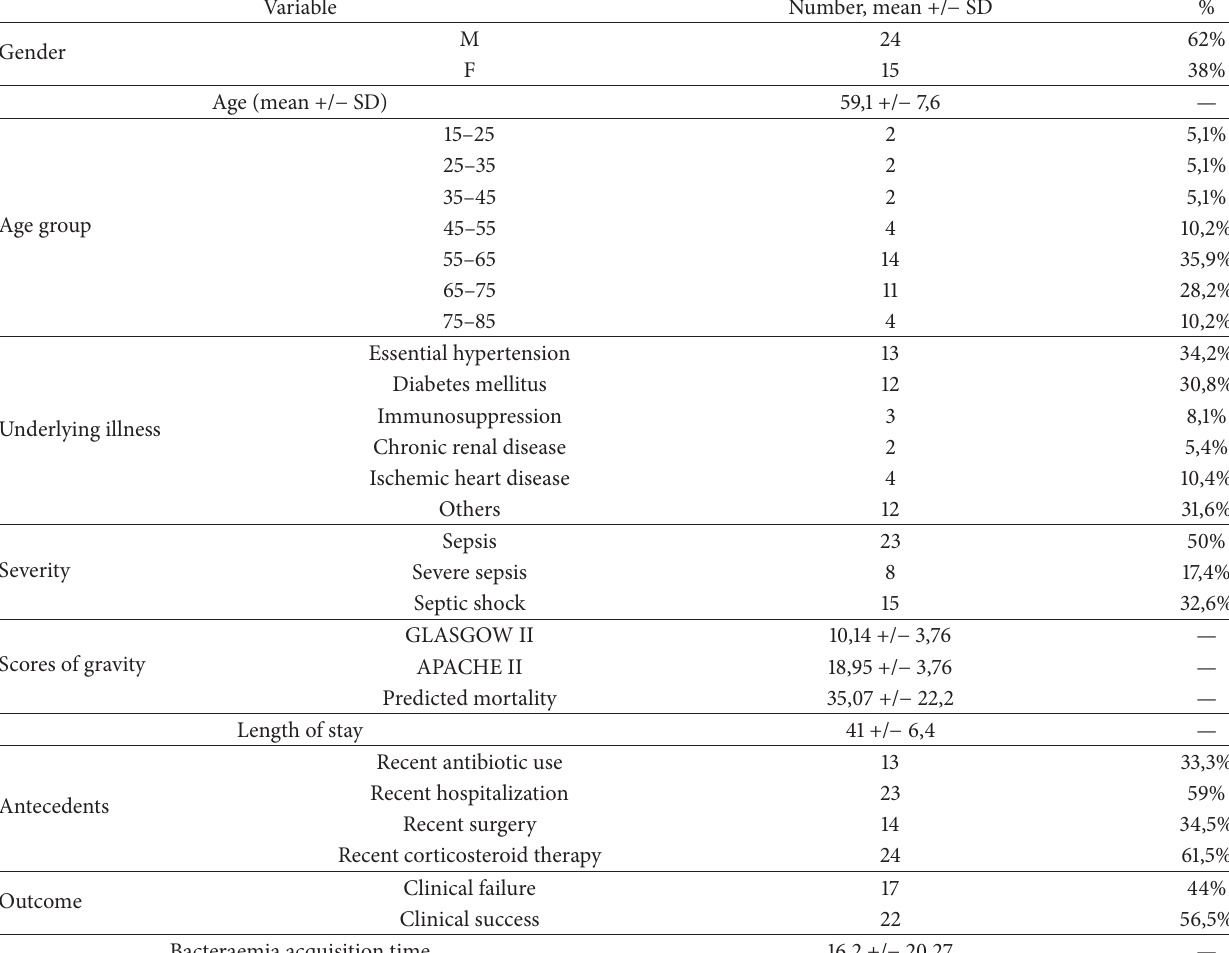
Table 1: Demographic and clinical data of the 39 patients involved in the